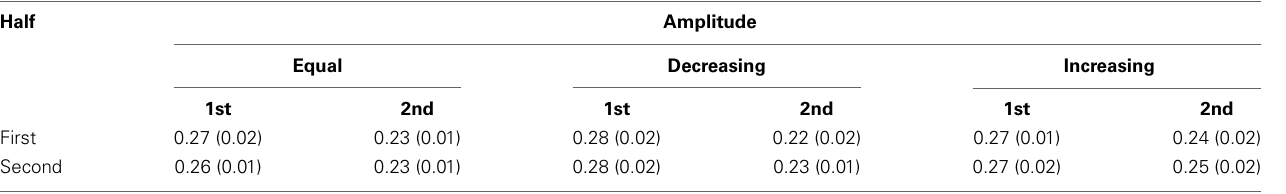
Table 4 | Mean speed of hand movement for the interaction half × quarter ×